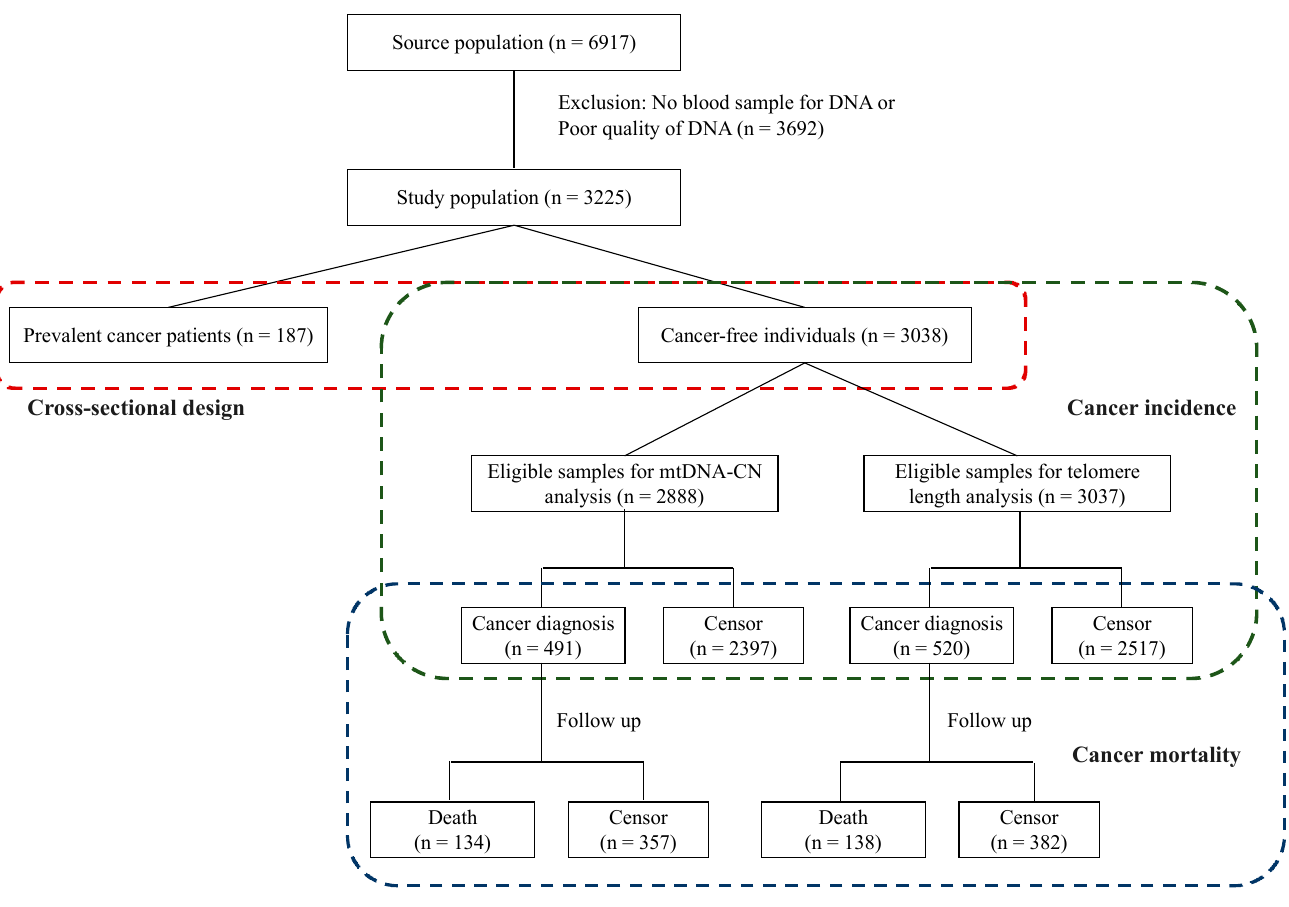
Figure 1. Flow chart of participants in this cohort study.